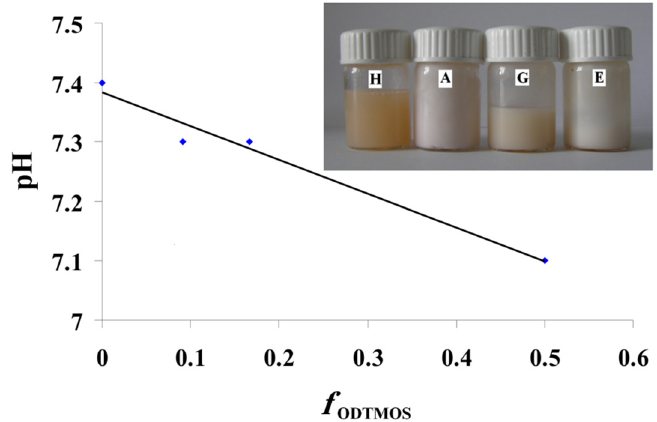
Figure 4. The modification of pH depending on the ODTMOS fraction; Inset picture : The dispersions prepared at OLA/Na 2/1 (mole/mole) and 0/1( sample H ); 1/1 ( sample A ); 1/5 ( sample G ) and 1/10 ( sample E ) (ODTMOS/SiO 2 (mole/mole)).